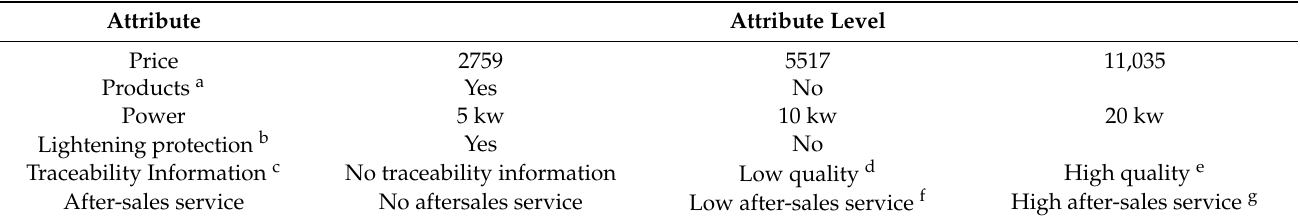
Table 1. Attributes and levels used in the choice